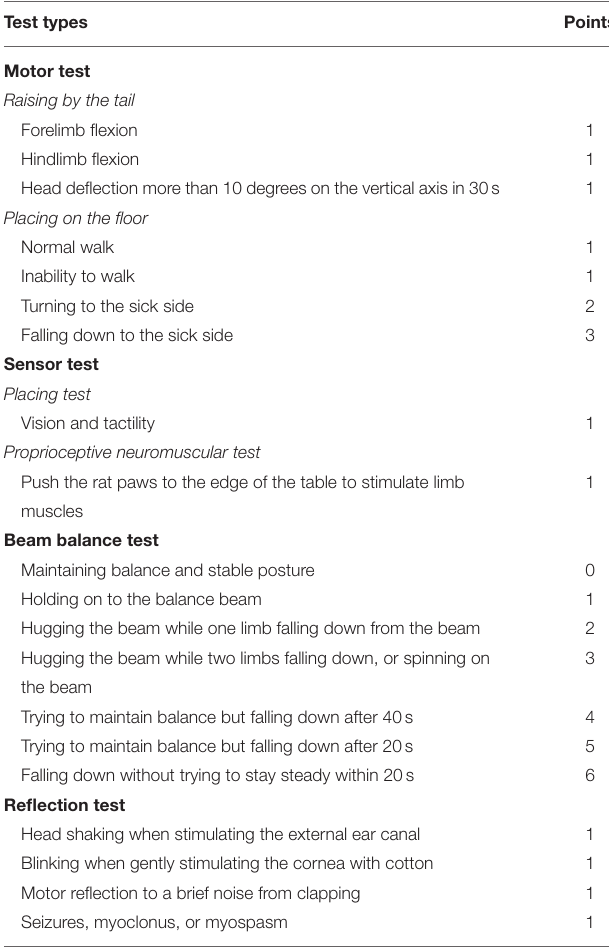
TABLE 1 | The scoring scheme of the modified neurological severity score (mNSS) based on motor, sensor, beam balance and reflection